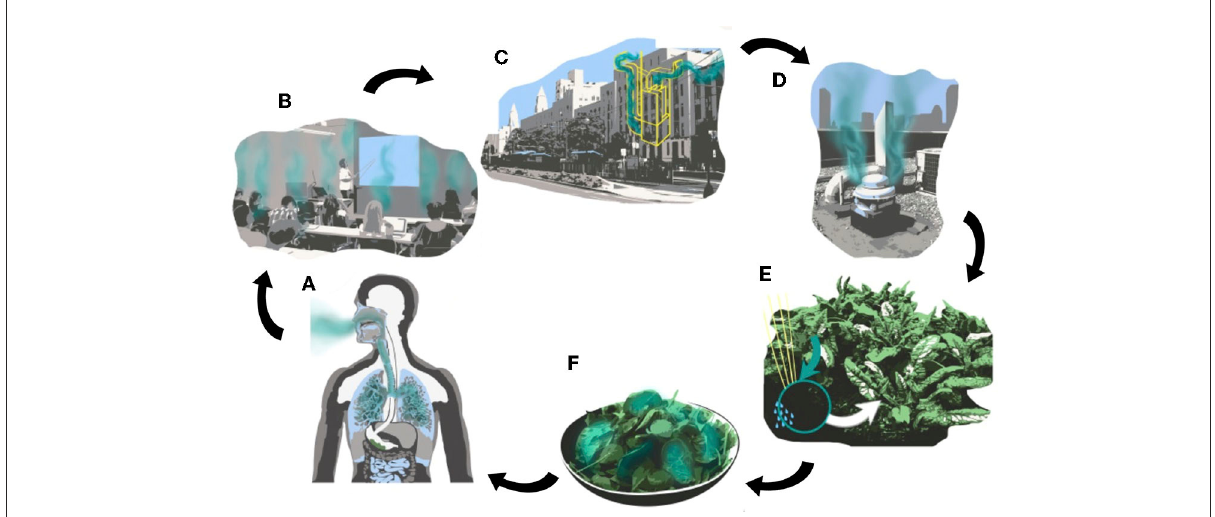
FIGURE1 Conceptual diagram showing the carbon cycle within experimental rooftop farms. In the more circular part of this system, CO 2 travels (A) from the human body (B) out into the classroom within a building. This CO 2 then is brought (C) through the ventilation system to the rooftop and (D) released through an exhaust vent. BIG GRO will apply this CO 2 to (E) plants in a rooftop farm after which (F) humans can consume the crops and the carbon can return to the human